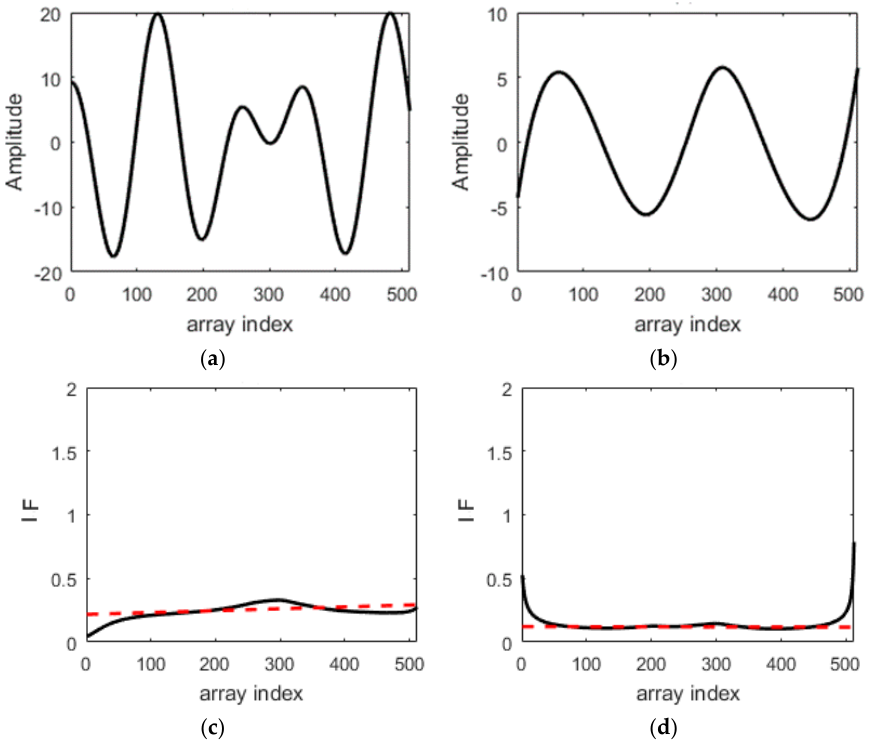
Figure 3. The resulting IMFs ( a , b ) as well as spatial IFs ( c , d ) using HHT.